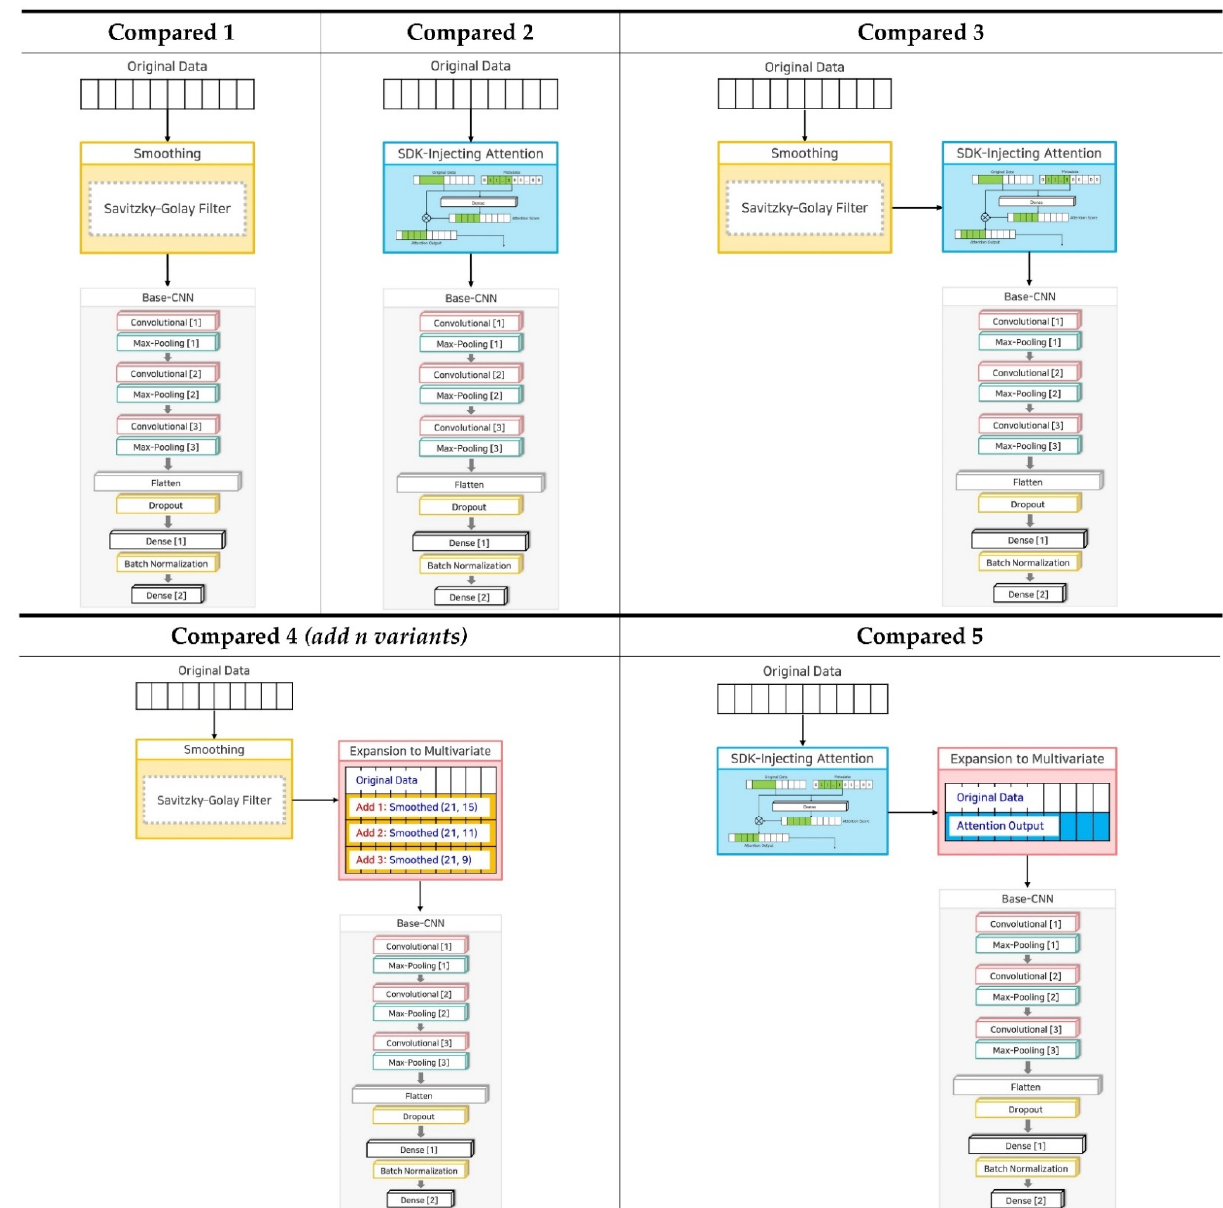
Figure 10. Schemes of other comparison methods (from Compared 1 to Compared 5) derived from the combination of three